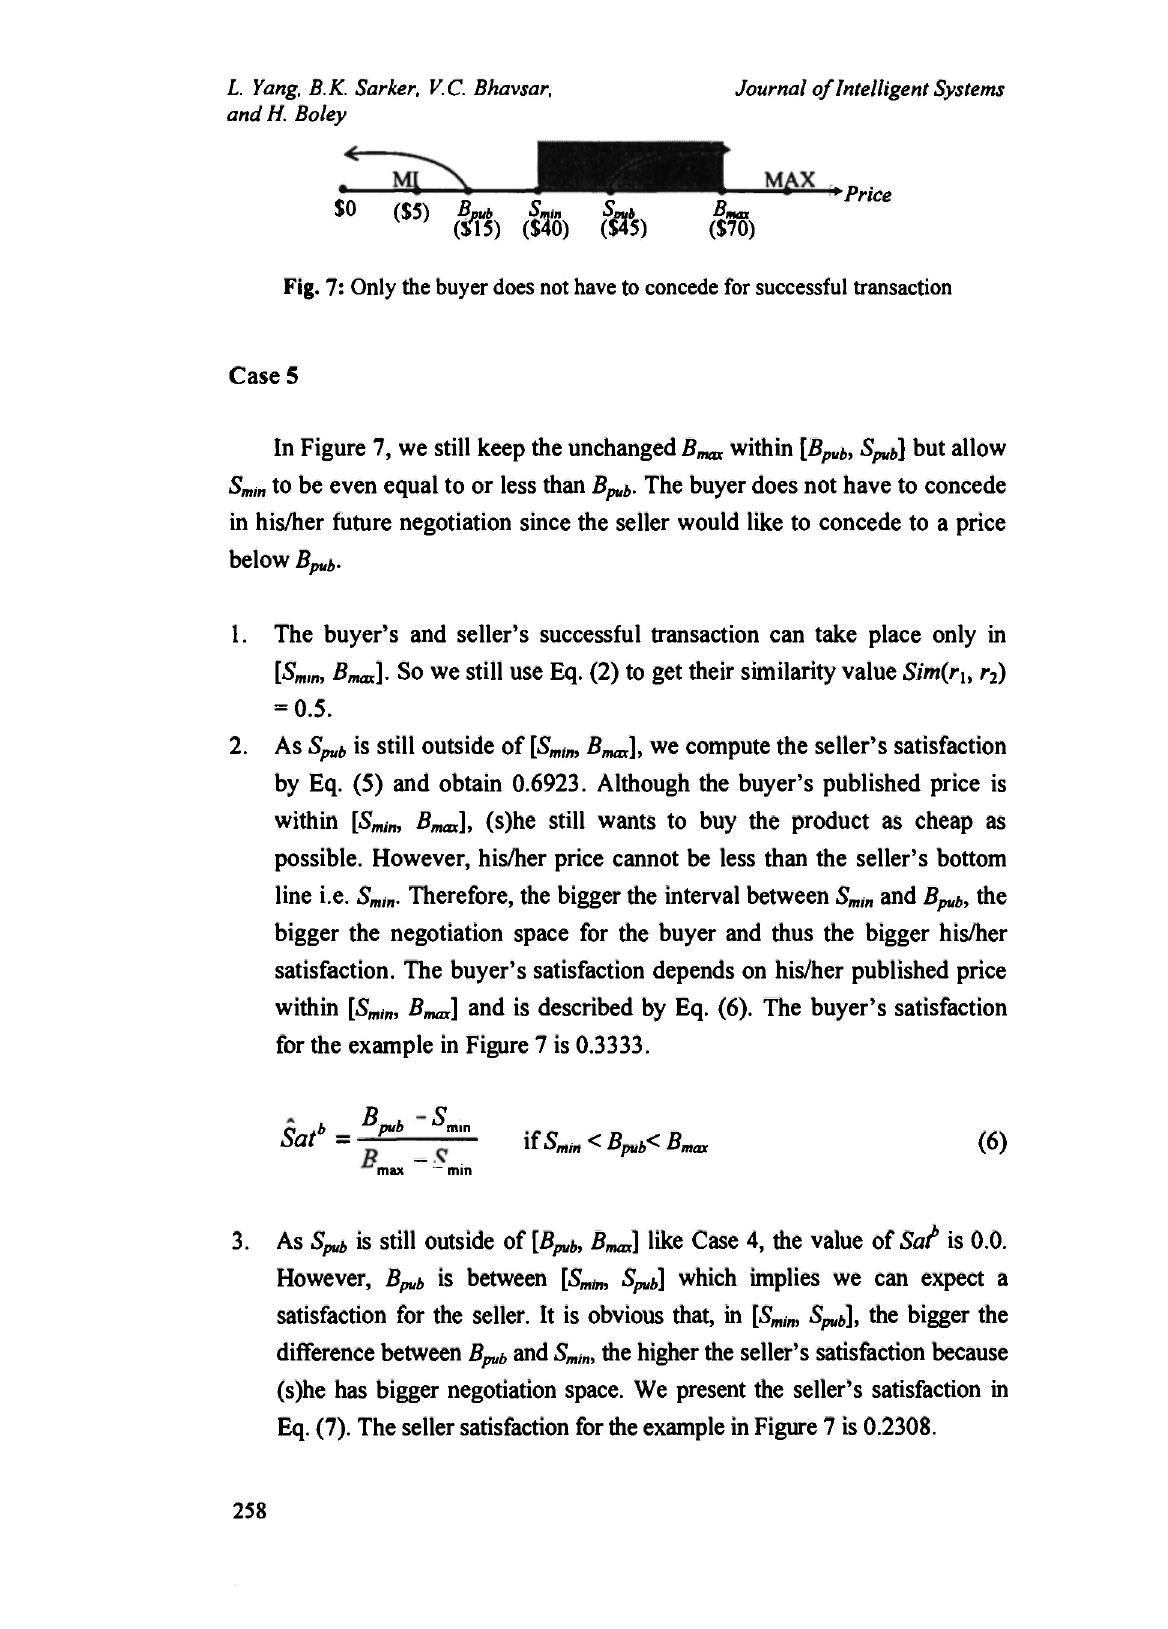
Fig. 7: Only the buyer does not have to concede for successful transaction